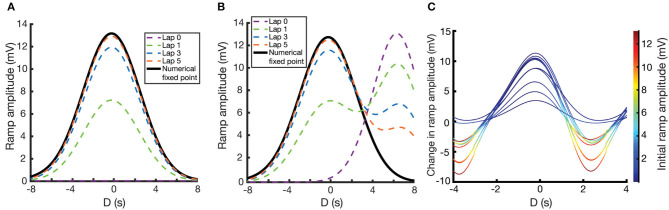
Place field plasticity on a linear track. (A,B) Simulated evolution of ramp amplitude over laps (dashed lines) and the numerically calculated fixed point ramp amplitude (solid lines) as a function of D. For (A), initial weights are set to zero. For (B), weights are initialized such that there is a preexisting place field at D = 7.0 s. (C) Change in ramp amplitude as a function of D and the initial ramp amplitude, for 10 different simulations. To replicate experiment, each simulation has a random selection of initial place field strength, plateau potential strength, and plateau potential location. These response curves replicate the results of Figure 1J of Milstein et al. (2020), with the caveat that our response curves are smoother and more uniform since we are assuming a uniform velocity.